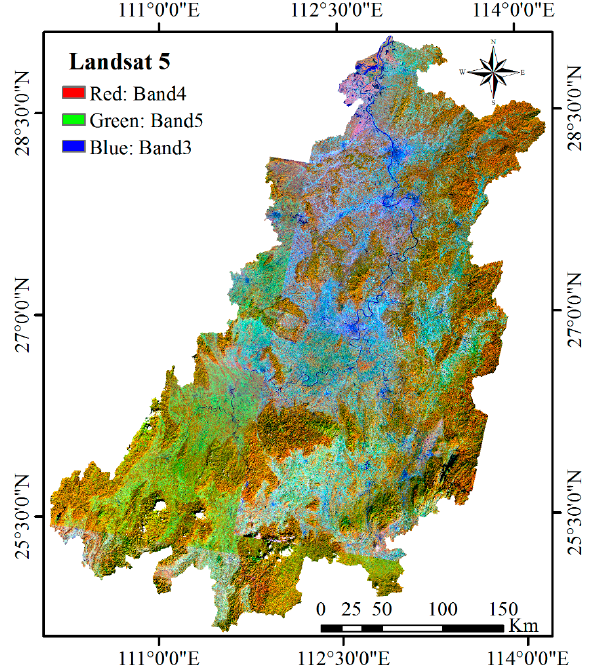
Figure 3. Landsat 5 TM composite image covering the study area after pre-processing.